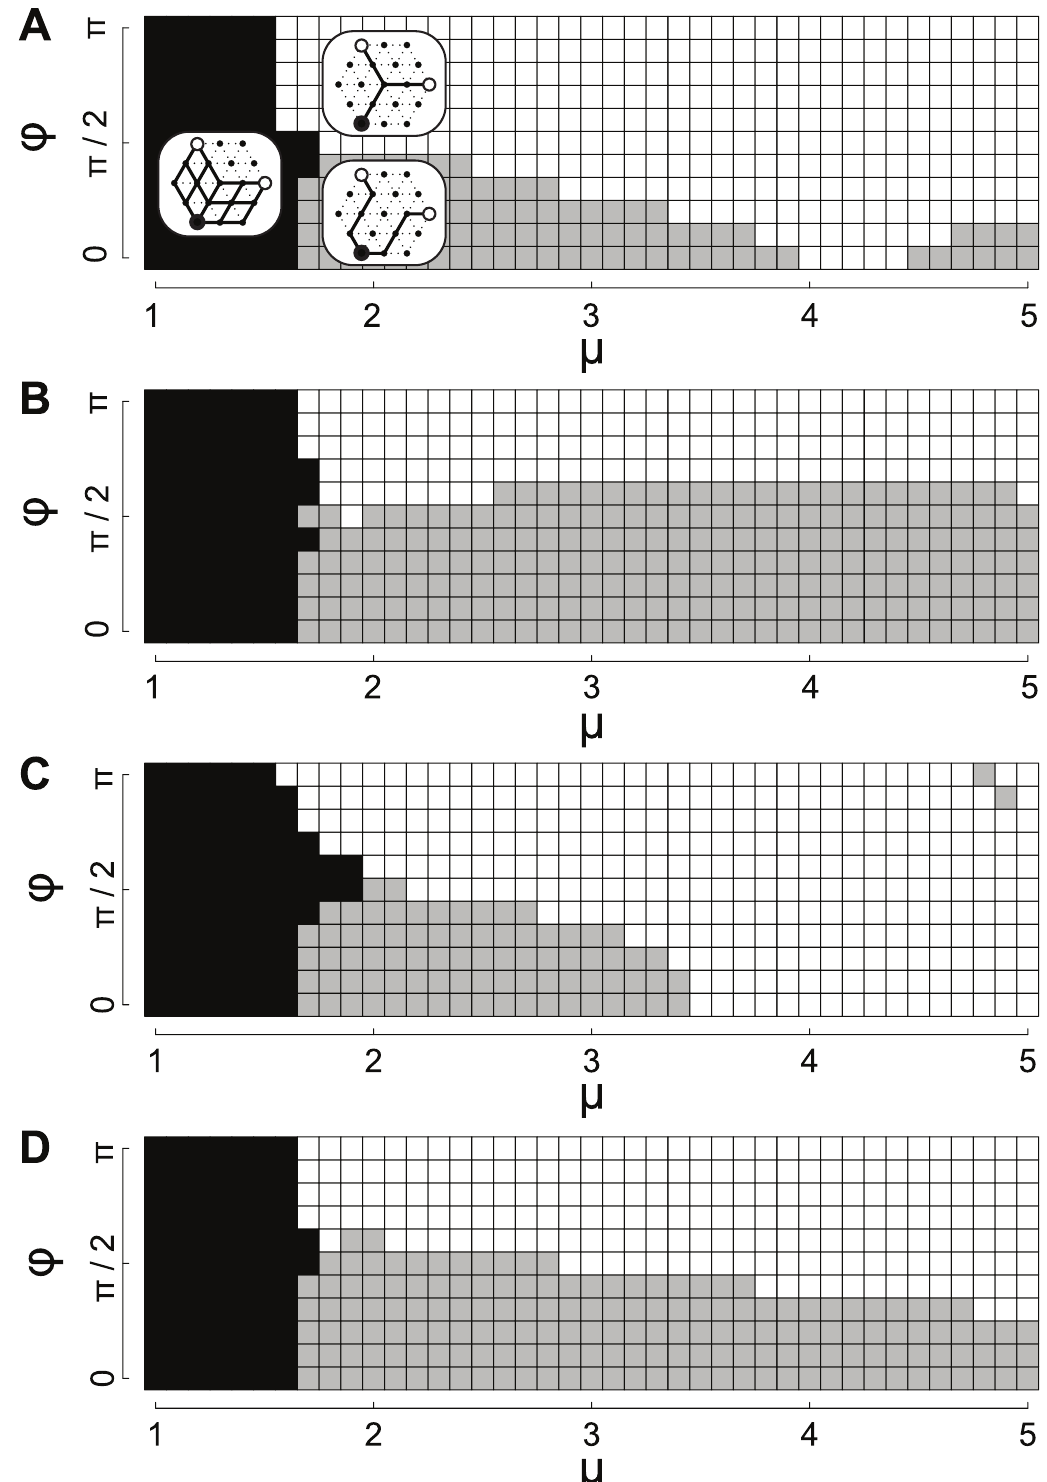
Figure 4. Relation between network types and the parameters m and under oscillating conditions. A Homogeneous initial condition of D ij ~ 1 : 0 { D Examples of non-homogeneous initial condition of D ij : Initial values of D ij were distributed according to a normal distribution with mean 1.0 and standard deviation 0.1. Black, gray, and white squares denote partial mesh, V-shaped and Y-shaped networks, respectively. The specific type-number of partial mesh depends on both parameters m and (Fig. S2), and also on the initial condition of D ij , which is not shown here in detail.